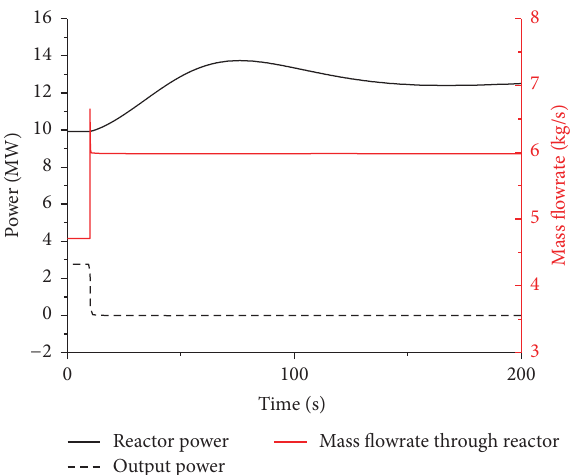
Figure 5: Mass flowrate and power responses of reactor when bypassing the turbine alone.